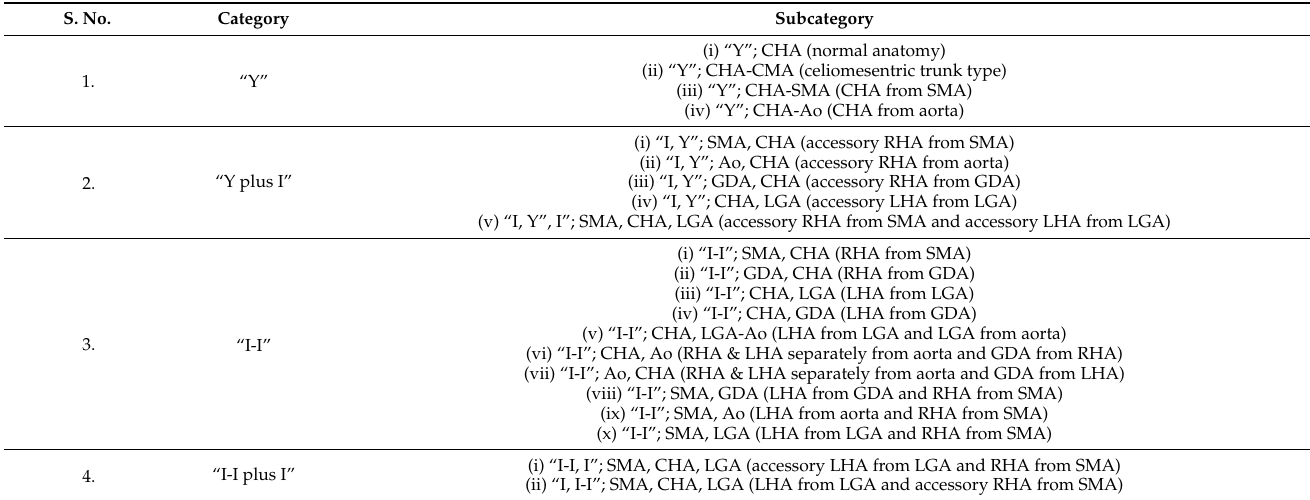
Table 2. Showing the anatomical variations of the hepatic artery based on the Kobayashi classification